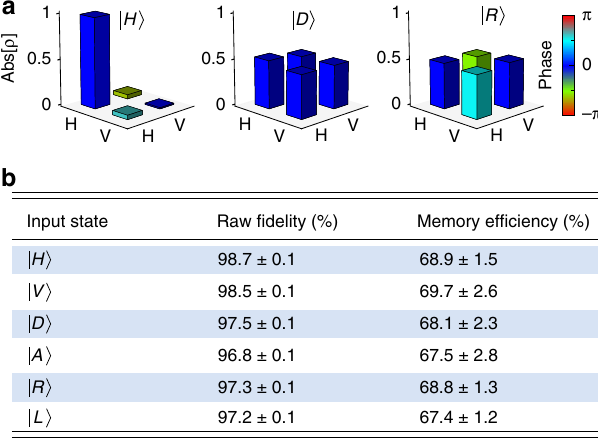
Fig. 4 Storage and retrieval beyond classical benchmark. The fi delity is given as a function of the mean photon number per pulse n , for a 1- μ s storage time. The inset shows the fi delity as a function of the storage time, for a mean photon number n ¼ 0 : 5. No background correction has been applied. The blue solid line indicates the classical limit for the fi nite storage and retrieval ef fi ciency and takes into account the Poissonian statistics of the weak coherent states. The error bars are smaller than the data points and are given by the standard deviations of fi delities for the set of stored